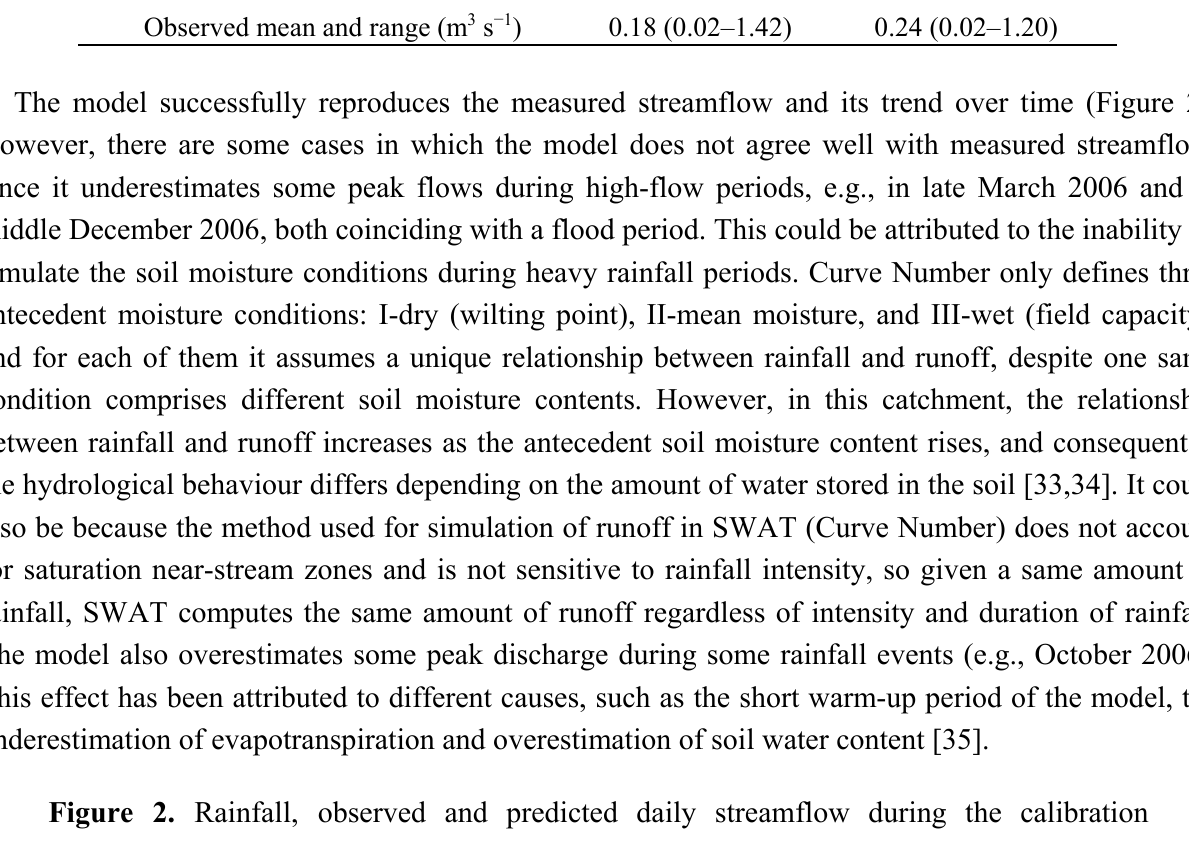
Figure 2. Rainfall, observed and predicted daily streamflow during the